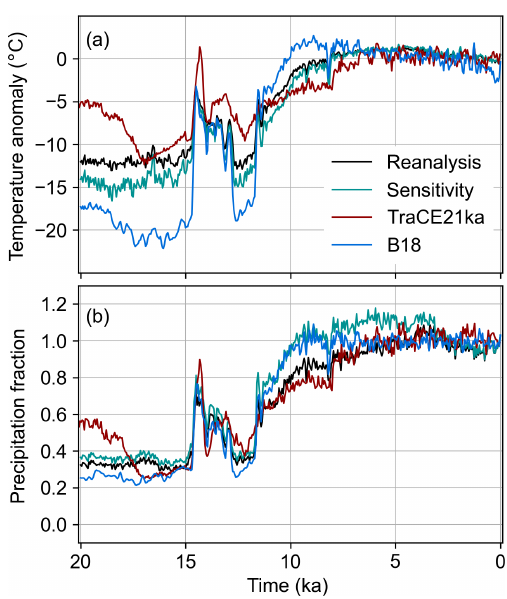
Figure 13. Temperature (a) and precipitation (b) reconstructions from our main reanalysis (black), our sensitivity scenarios S4 and high P (green), TraCE-21ka (red), and B18 (blue) (Buizert et al., 2018). Each reconstruction is averaged to a 50-year time resolu- tion and averaged over a spatial domain in the Kangerlussuaq re- gion, defined by the latitude-longitude box 65 to 68.7°N and 48.5 to 52.5°W, the center of which is located at the star in Fig. 11a. Temperature anomalies and precipitation fraction are defined with reference to the mean of 1850–2000